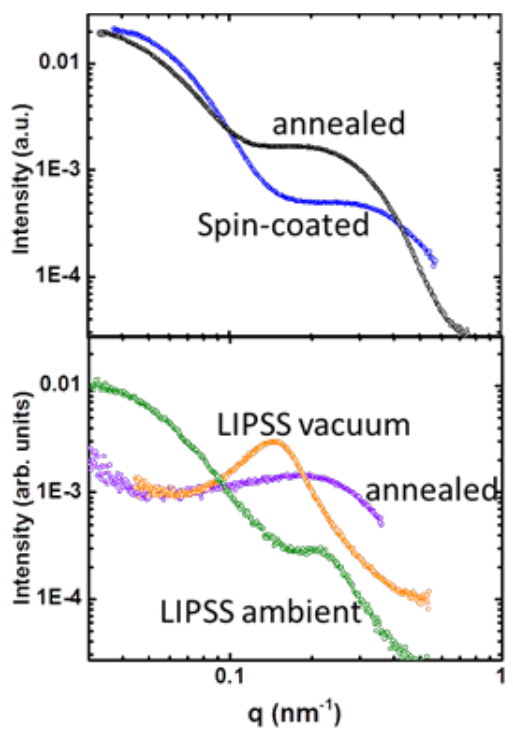
Figure 7. Integrated meridian intensity as a function of the modulus of the scattering vector for the different investigated samples. Upper panel: P3HT:PC 71 BM (1:1) spin-coated film (blue), annealed P3HT:PC 71 BM spin-coated film (black). Bottom panel: LIPSS P3HT:PC 71 BM (1:1) at λ laser = 266 nm in ambient conditions (green), λ laser = 266 nm in vacuum (orange), annealed LIPSS P3HT:PC 71 BM (1:1) ( λ laser = 266 nm in vacuum) (purple).